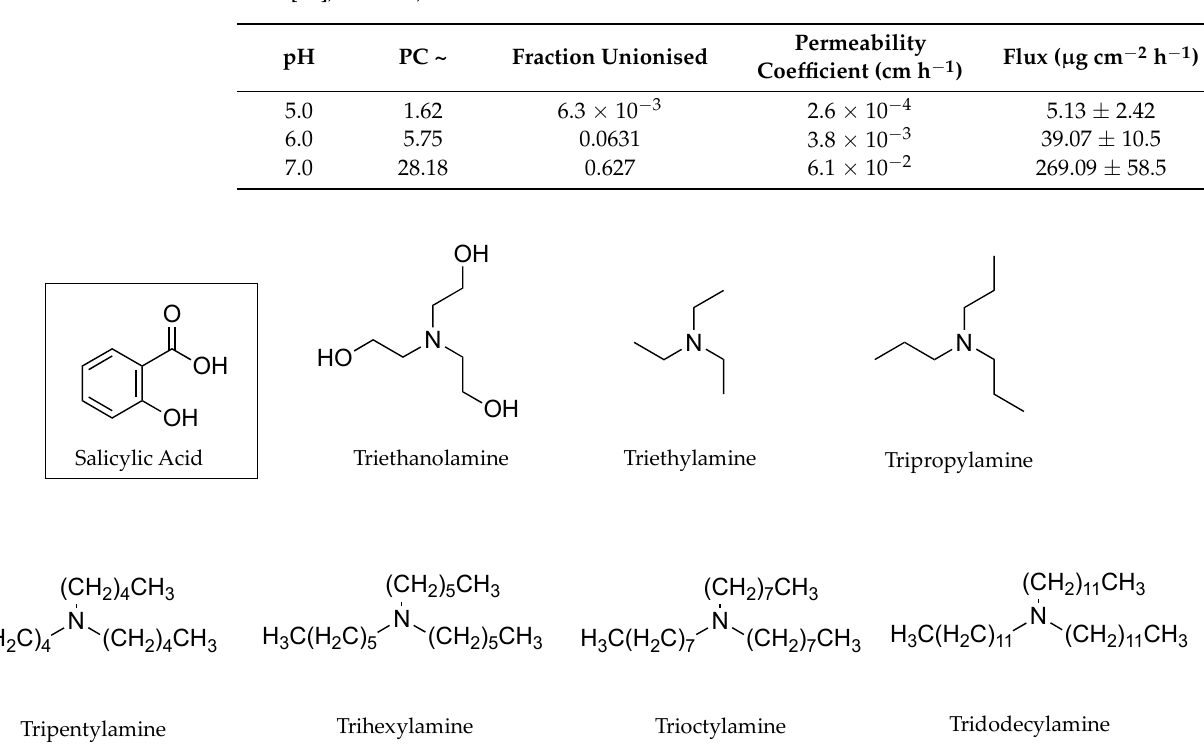
Figure 3. Salicylic acid the counter ions, triethanolamine, triethylamine, tripropylamine, tripentylamine, trihexylamine, trioctylamine and tridodecylamine.